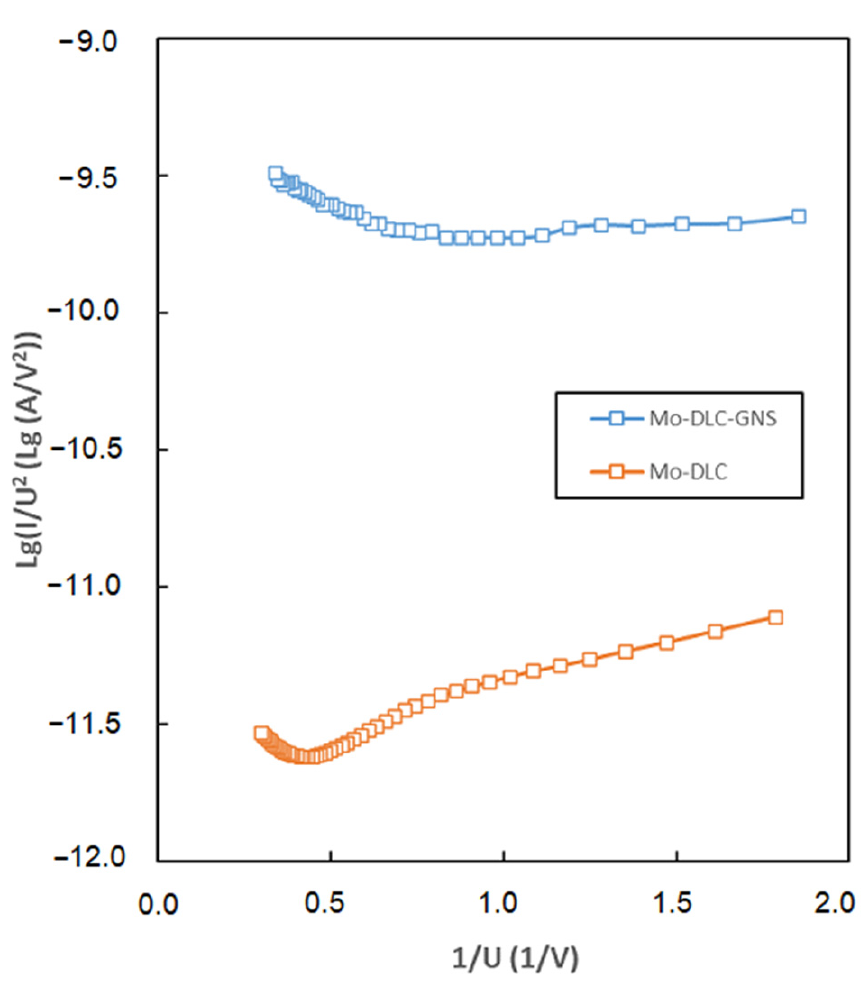
Figure 6. Results of measurement of volt-ampere characteristics plotted in Fowler–Nordheim coordi- nates for emission structures of two types—“Mo-DLC” and “Mo-DLC-GNS”. As can be seen from the data in Figure 7, the relative increment of the photocurrent (determined by the difference between the tunnel current I laser of the sensor-emitter under laser irradiation and the tunnel current I dark in the absence of irradiation) increases mono- tonically with increasing U . The increment of the photocurrent ( I laser − I dark ) is normalized to the value of the maximum I 0 of the dark current, registered when changing U in the studied range. It follows from Figure 7 that even at relatively low U , the photocurrent reaches almost 18% of the field emission current I 0 when irradiated with a green laser and 21% when irradiated with a red laser. In both cases, there is a tendency for the photocurrent to further increase with increasing U . Despite the fact that the exposure power P 532 of the green laser is 5 times higher than the power P 662 of the red one, the photocurrent in the latter case turned out to be higher. This is clear experimental proof of the efficiency of using plasmonic nanoparticles irradiated by a laser beam at a resonant wavelength to generate tunneling photoelectrons. It should be especially noted that this result was obtained in the regime of irradiation with a low-power CW laser source, and the photon energy is much less than the work function of electrons from the metal. For the convenience of comparative evaluation of the proposed “Mo-DLC-GNS” structure with analogues in terms of a set of parameters that determine their suitability for use in high-performance and safe X-ray CT systems, the information is summarized in Table